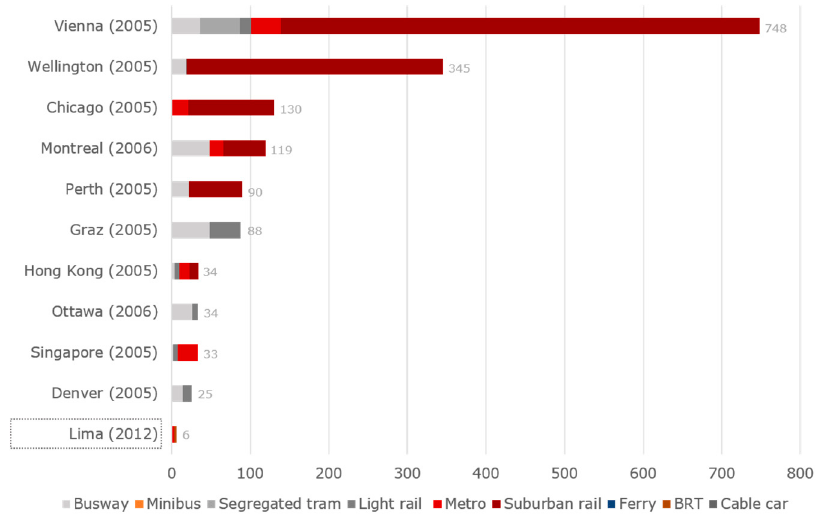
Figure 9. Length of reserved transit routes per 1000 people (m / person). Source: References [47,57,63]. Graph by authors.